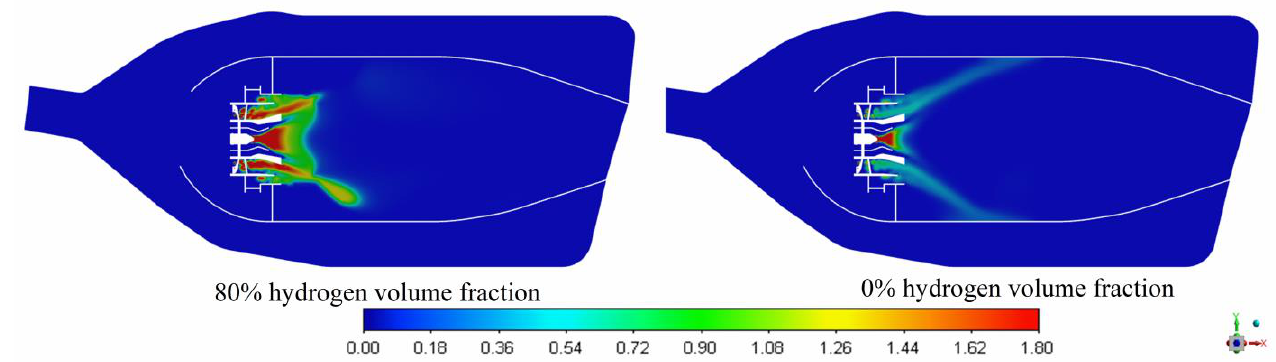
Figure 8. The equivalence ratio distribution under different hydrogen volume fractions.